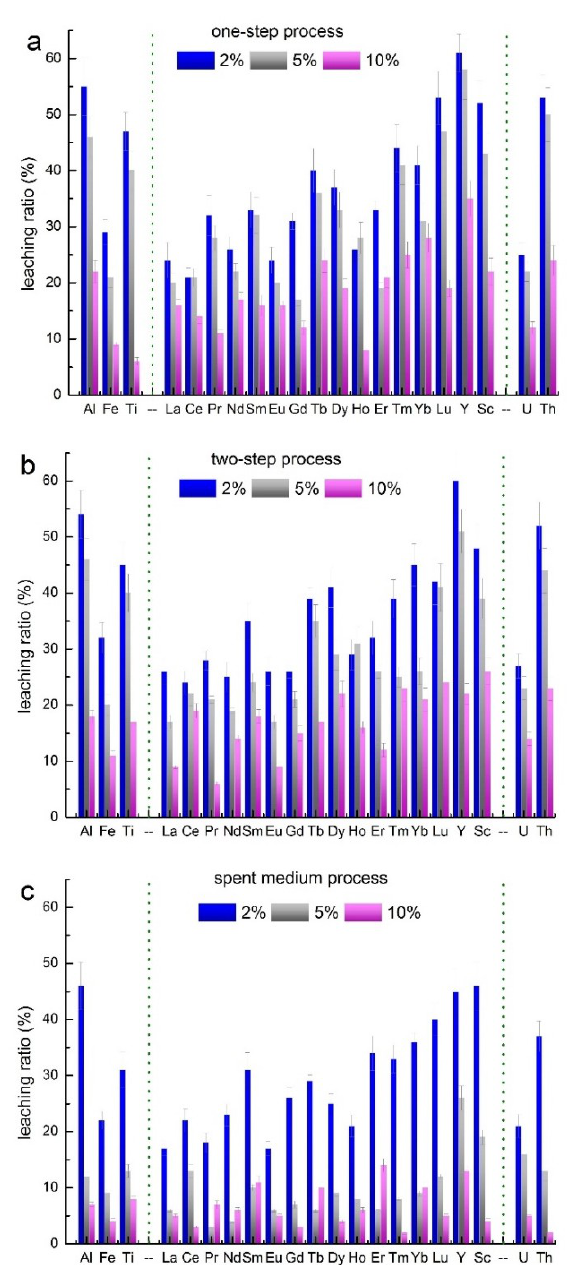
Figure 3. Leaching efficiencies of major elements, REEs and radioactive elements at different RM pulp densities under ( a ) one-step process, ( b ) two-step process, and ( c ) spent medium process.